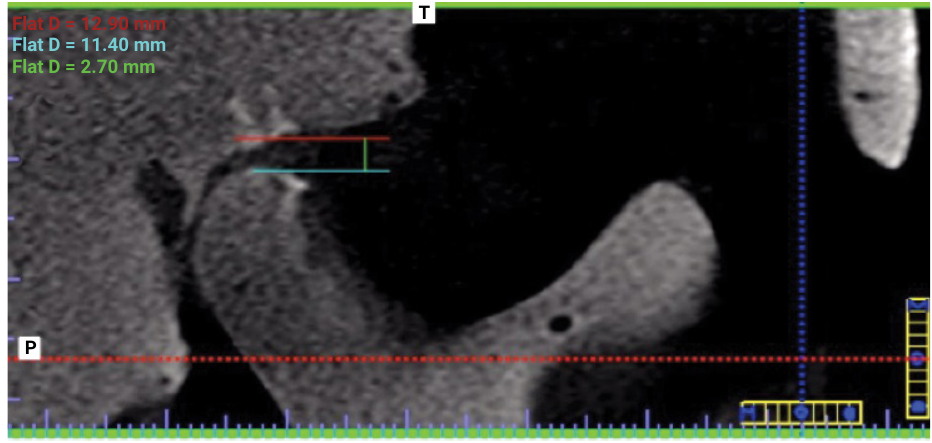
Figure 6. Measuring changes between the vertical distances of the metallic markers (screws) on the sagittal reformatting. Perpendicular lines (blue and red) from the top of the head of the screws were done using the DISTANCE tool of the software and the distance between them were measured (green vertical line). In this picture, the green line represents the vertical distance between the upper and lower lines and it was 2.70 mm